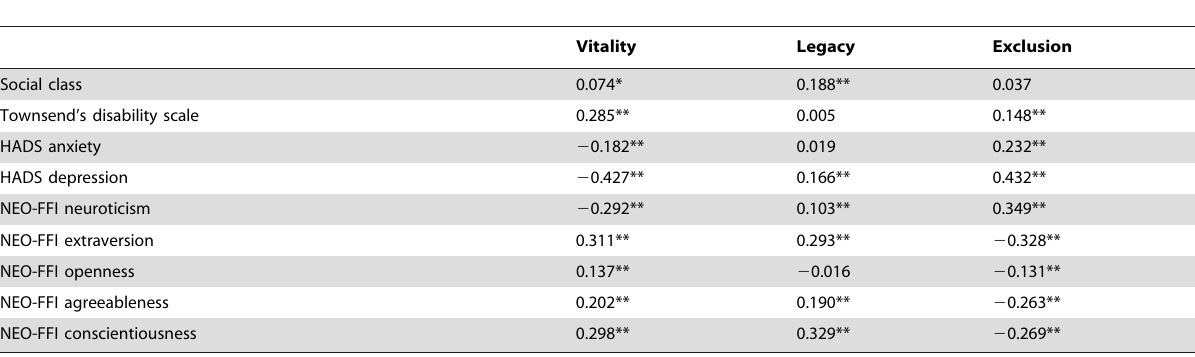
Table 7. Pearson’s correlation between AAQ dimensions and a range of